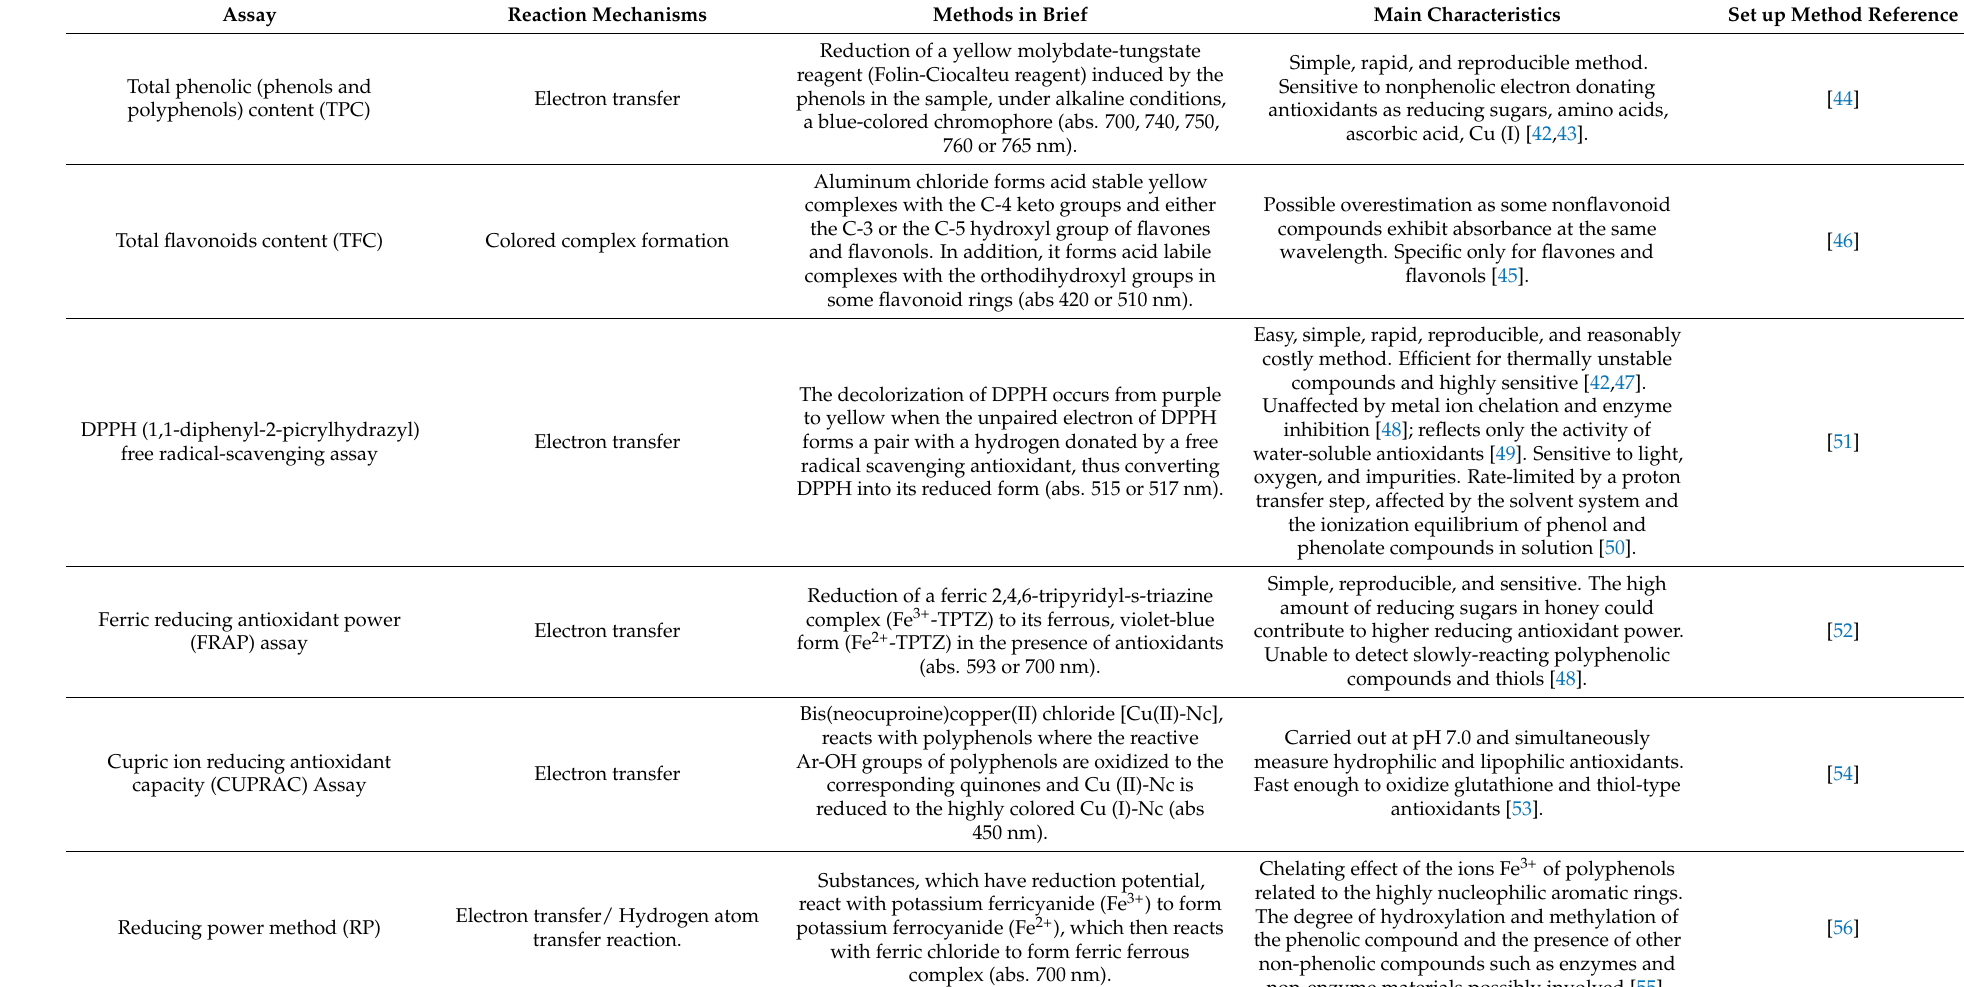
Table 1. Summary of the assays used for antioxidant capacity